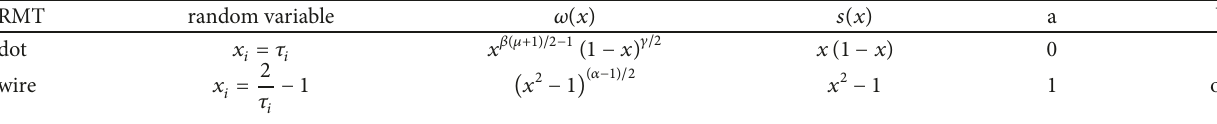
Table 1: Classification of Brownian motion ensembles for the BdG